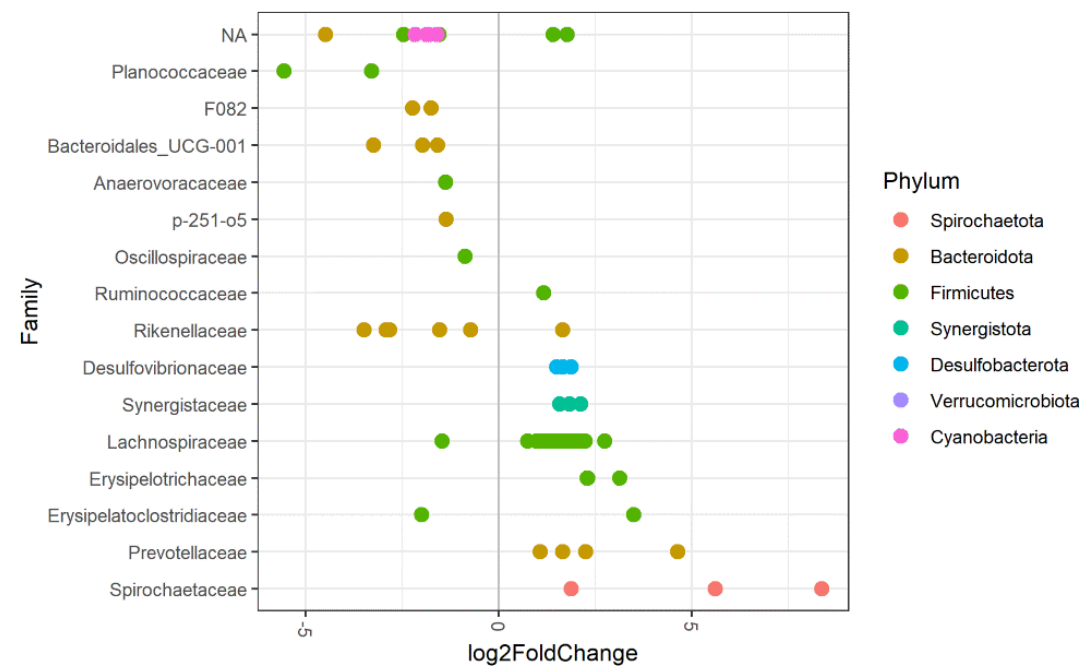
Figure 6. Differentially abundant ASVs grouped by family for season of sampling (winter vs. summer) of the faecal microbiota in 61 horses and ponies. The log2 fold change in species abundance is shown on the x -axis. ASVs assigned to bacterial families on the left side of the plot are less abundant in samples collected in winter compared to samples collected in summer, ASVs assigned to families depicted on the right side of the plot are more abundant samples collected in the winter compared to sampled collected in the summer. NA = ASV belonging to an unknown family (colours indicate the phylum).